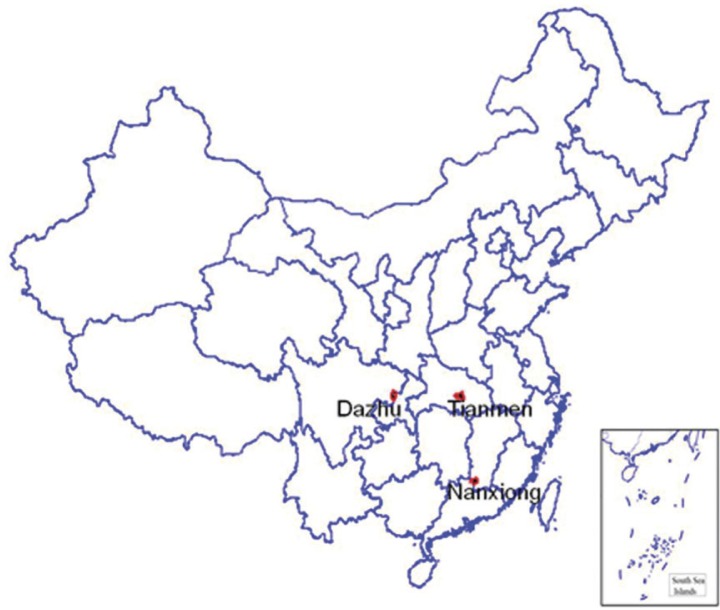
The location of three pilot sites as surveillance points in China, 2010.Three surveillance points performed the oral examination and self-reported oral behavior. Respondents in Dazhu county represented the rural residents, and respondents in Nanxiong and Tianmen city represented urban residents.